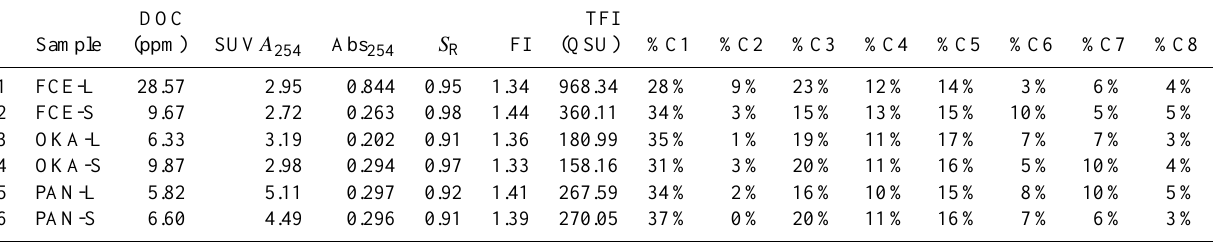
TFl = total fluorescence (QSU), %CX = relative abundance of PARAFAC component X, L and S indicate long or short hydroperiod.